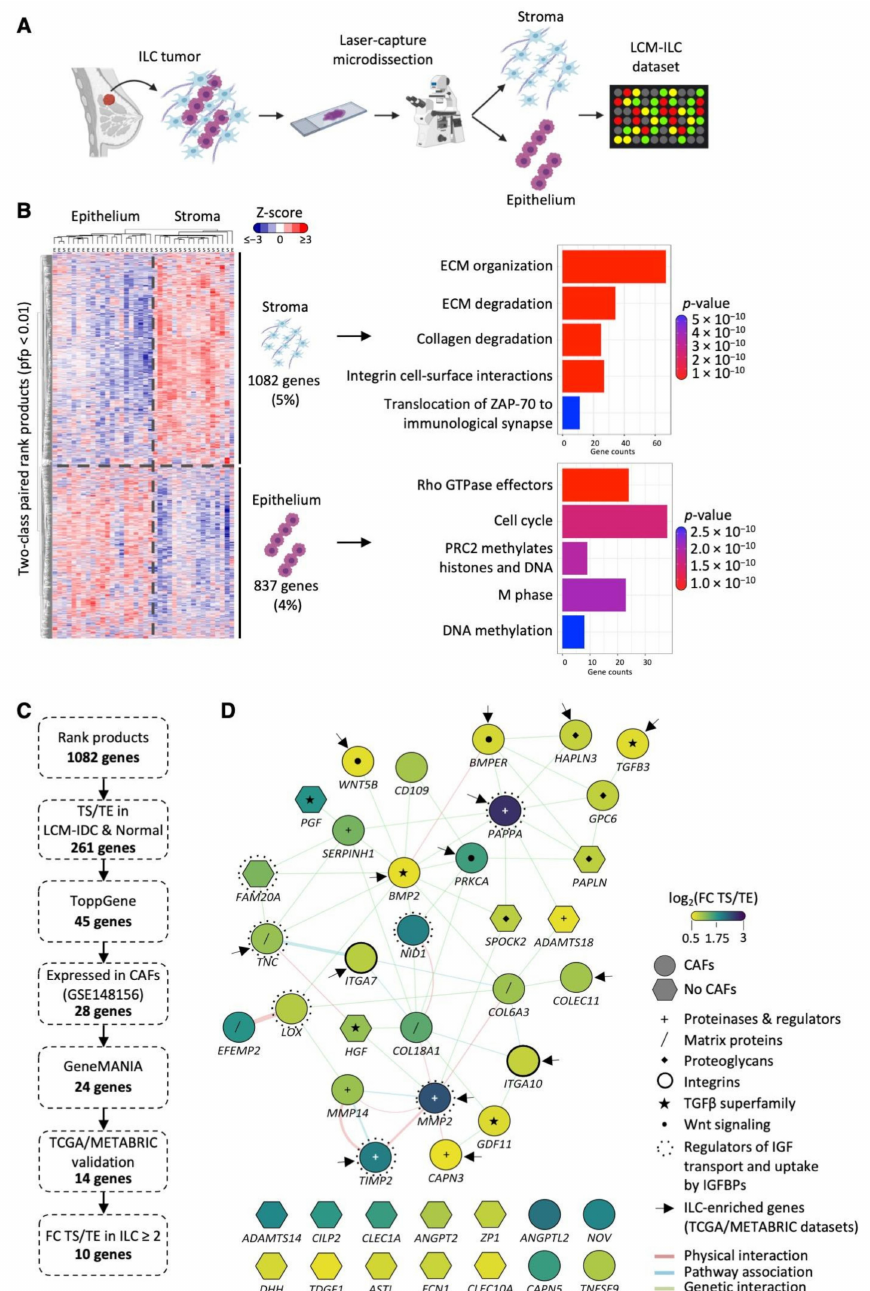
Figure 1. Identification of stromal genes enriched in ILC following LCM. ( A ) Schematic representation of the LCM experimental design (made in Biorender.com (accessed on 1 June 2020)). ( B ) Two-class paired differential gene expression analysis and Reactome pathway enrichment analysis of 22 tumor epithelial (TE) and 18 tumor stromal (TS) ILC samples dissected by LCM. Heatmap was generated using MultiExperiment Viewer (rank products, pfp < 0.01), Cluster 3.0 and TreeView. Z-scored expression values are shown. Reactome bar plot was generated in R. ( C ) Pipeline used for the selection of TS-ILC-enriched genes from the LCM-ILC dataset. ( D ) Interaction map of the 45 ECM- associated genes from ToppGene was generated using GeneMANIA in Cytoscape. Color represents the log 2 (fold change (FC)) expression in the TS compared to TE. Purple, log 2 (FC TS/TE) 3; green, log 2 (FC TS/TE) 1.75; yellow, log 2 (FC TS/TE) 0.5. Network connectors represent physical interactions (pink), pathway associations (blue) or genetic interactions (green). Arrows point to the 14 genes whose expression was significantly increased in ER+ ILC compared to ER+ IDC in TCGA and METABRIC